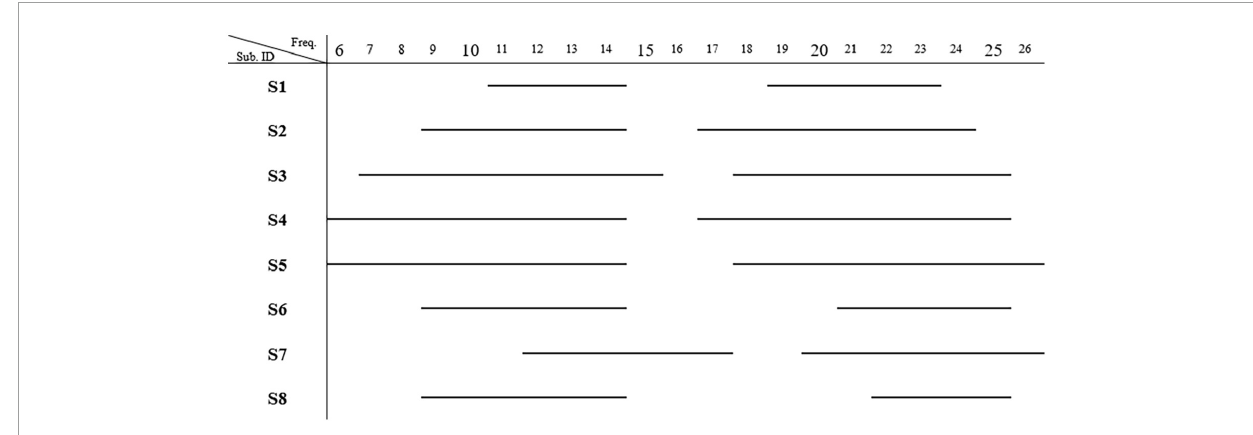
FIGURE4 Most representative frequency bands. The frequencies present significant band power changes in each subject. Two frequency bands showing significant power changes ( p < 0.01) were observed ( N = 8) after bootstrap analysis. The mu band was 11.3 ± 2.6 (mean ± SD) Hz, and the beta band was 21.8 ± 2.4 Hz.